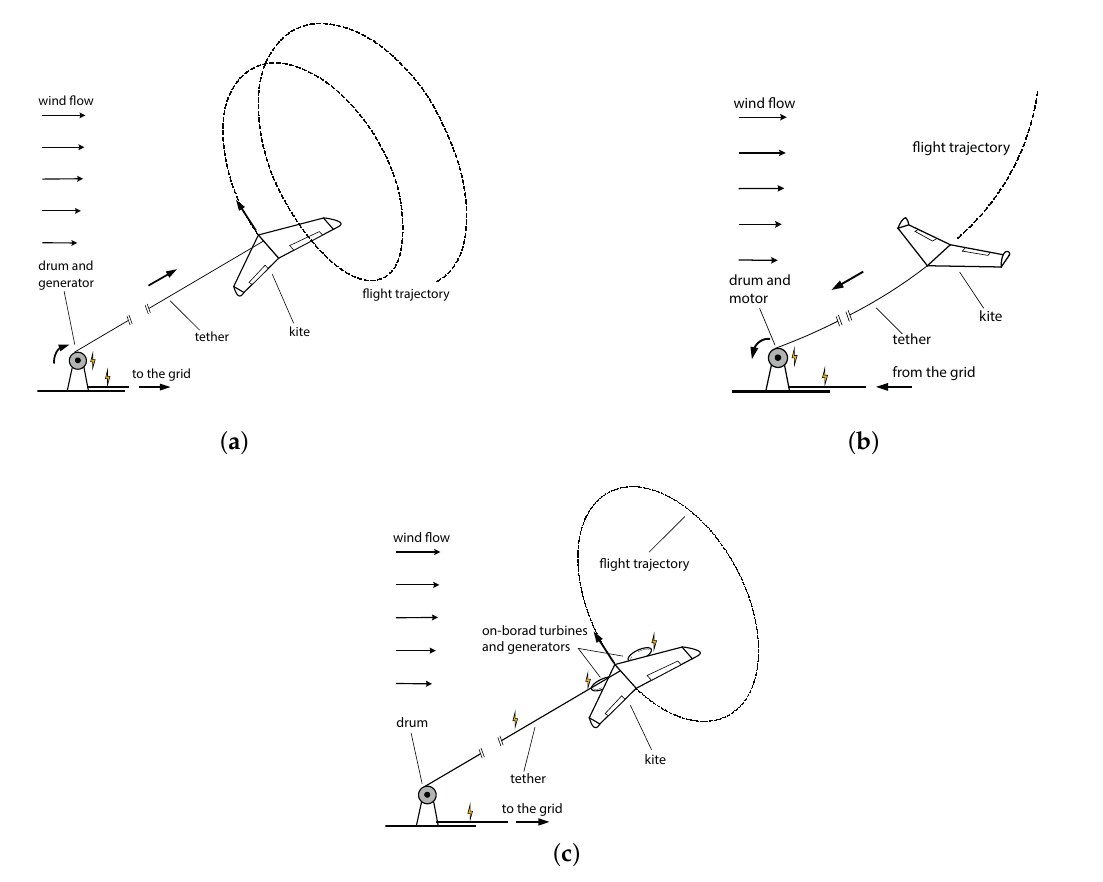
Figure 1. Schematic drawings of ( a , b ) ground-based (or lift mode or pumping mode), and ( c ) on-board (or drag mode), power generation via CKPSs. Subfigure ( a ) shows the reel-out or power generation phase, and subfigure ( b ) shows the reel-in or power consumption phase (adapted from